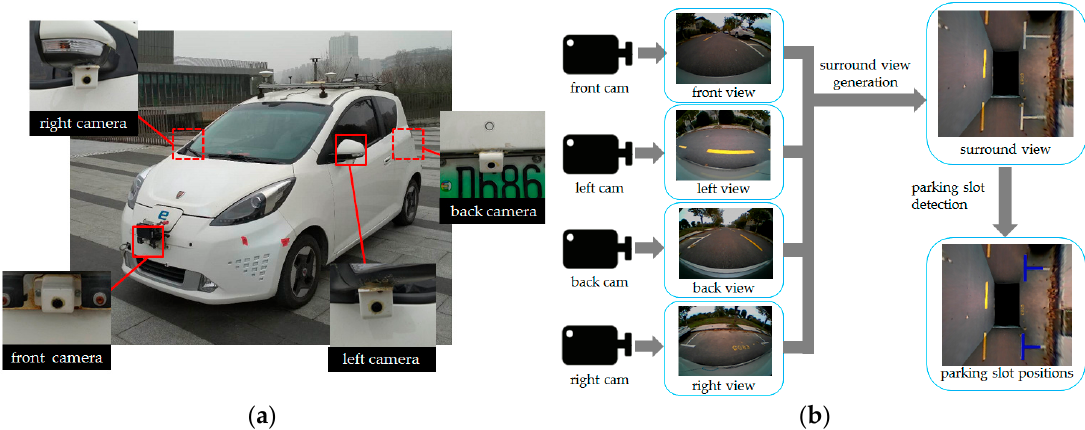
Figure 2. Surround view parking slot detection system. ( a ) Test vehicle and camera installation location. ( b ) Surround view generation and parking slot detection.